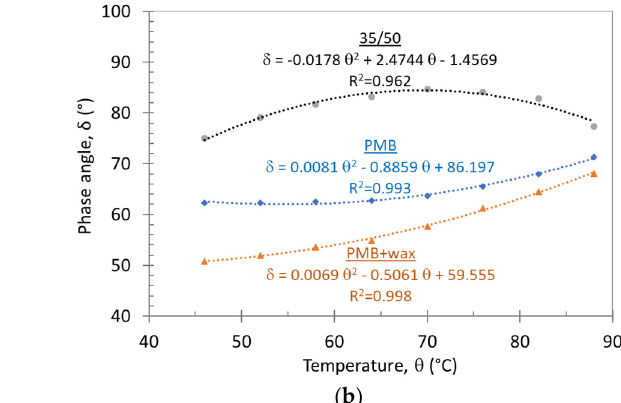
Table 6. Effects of three different waxes on the rutting resistance parameters of two PMB. Parameters